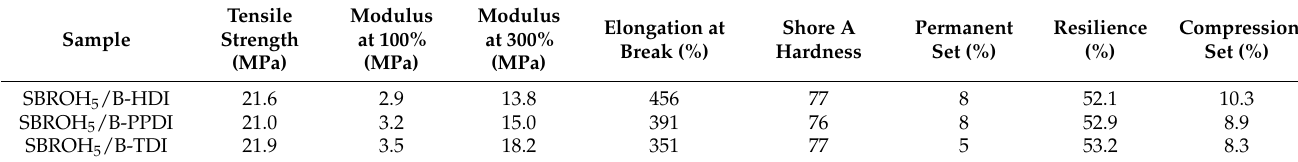
Table 4. Tan δ at 0 and 60 ◦ C of